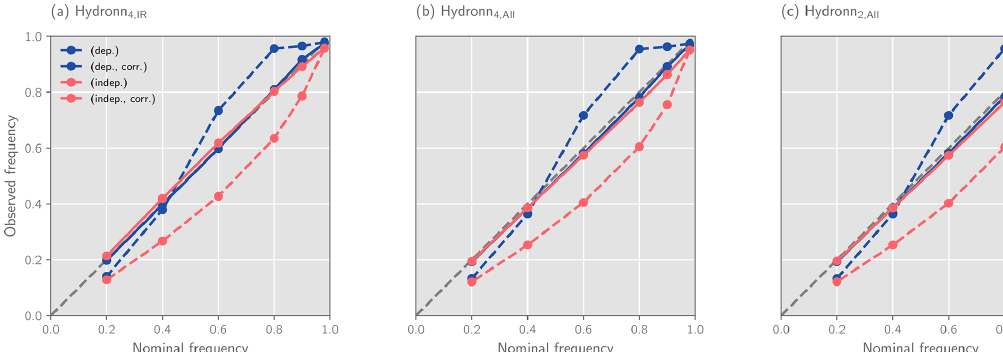
Figure A1. Like Fig. A1 but for June 2020.